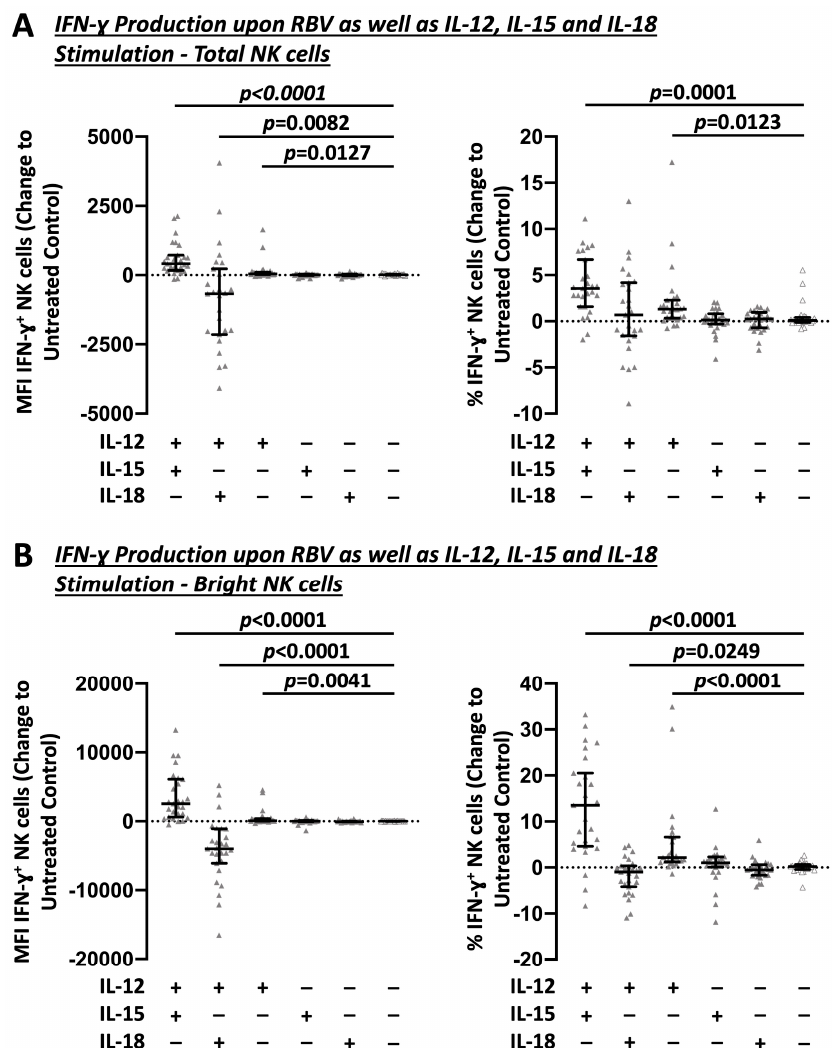
Figure 4. Impact of different sole and combined IL stimulations on RBV-treated NK cells. Flow cy- tometric analysis of IFN- γ production as change to untreated controls. MFI and frequencies com- pared. ( A ) Total NK cells. ( B ) Bright NK cells (n = 27). Appearance: median with interquartile range, statistical analysis: Wilcoxon matched-pairs signed-rank test.